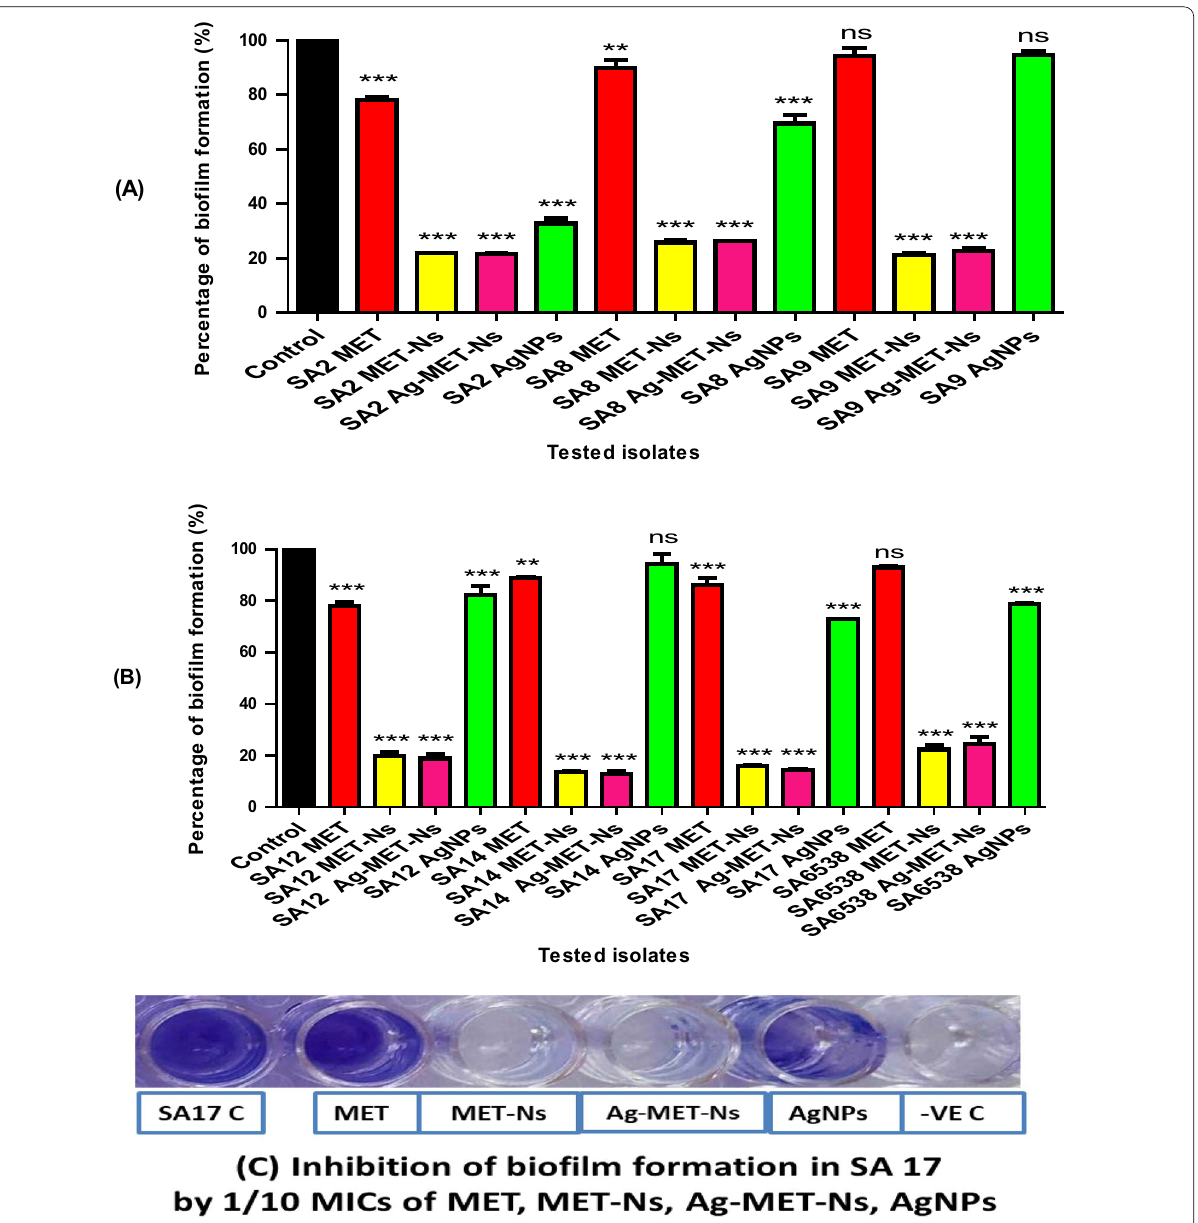
Fig. 2 Inhibition of biofilm formation in S. aureus by 1/10 MICs of the tested agents. Optical density was measured at 570 nm. Significant reduction of biofilm formation was found with 1/10 MICs of the tested inhibitors in the tested bacteria compared to controls. The data shown represent the means standard errors. * P < 0.05, ns; ±